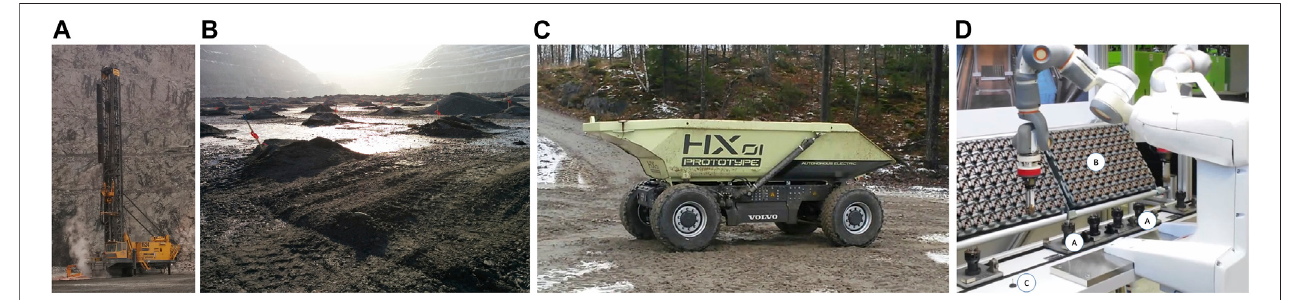
FIGURE 2 | Drilling machines and the resulting holes in an open-pit mine (a, b) , autonomous construction machines in a quarry (c) ; a dual-arm robot assembling wiper motors (d) .